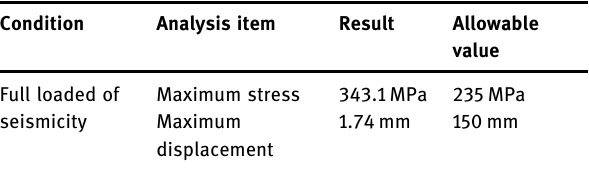
Table 4: Results of smart light poles under the seismic condition